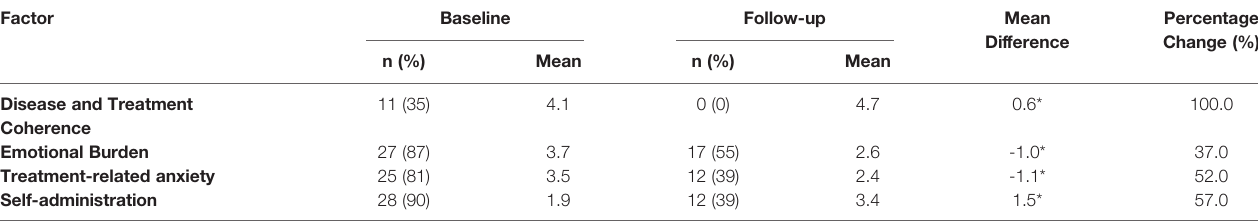
TABLE 1 | Changes in scores from baseline to follow-up. Factor